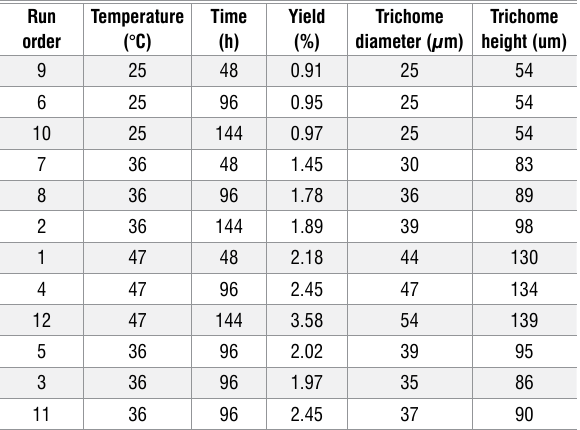
Table 1: Essential oil yield, trichome height, and trichome diameter of Lippia javanica at set experimental